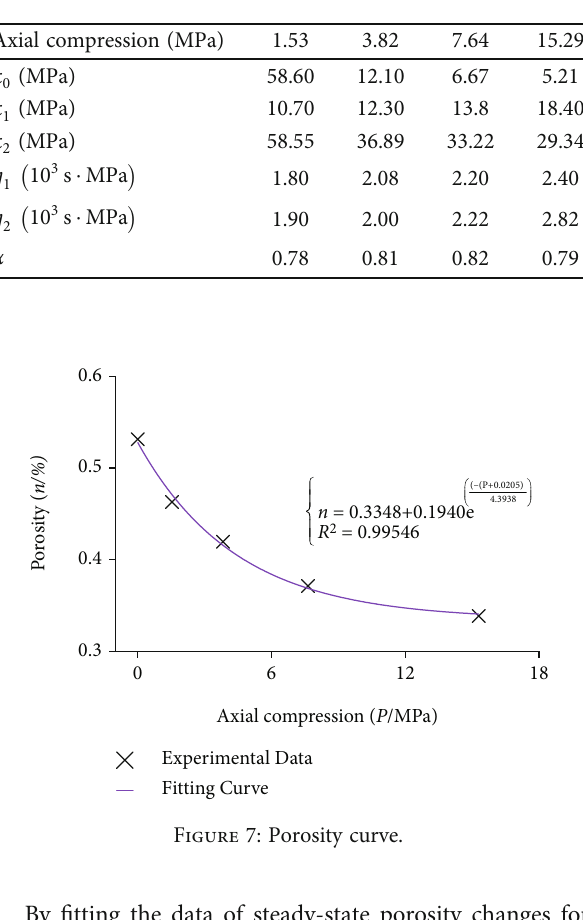
Figure 6: Rheological model fi tting curve obtained from test results. Table 1: Parameters of new fractional model.